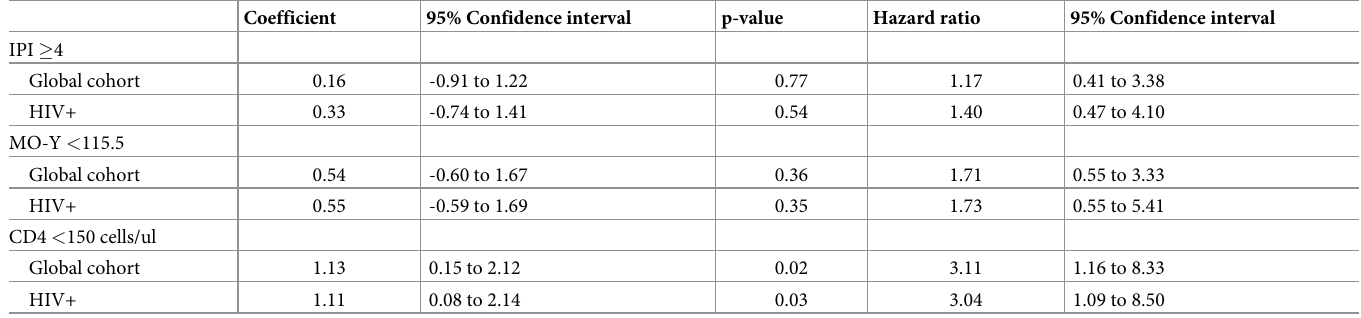
Table 8. Cox proportional-hazards regression analysis for independent associations between the survival time and the IPI, CD4 count and a MO-Y < 115.5. Coefficient